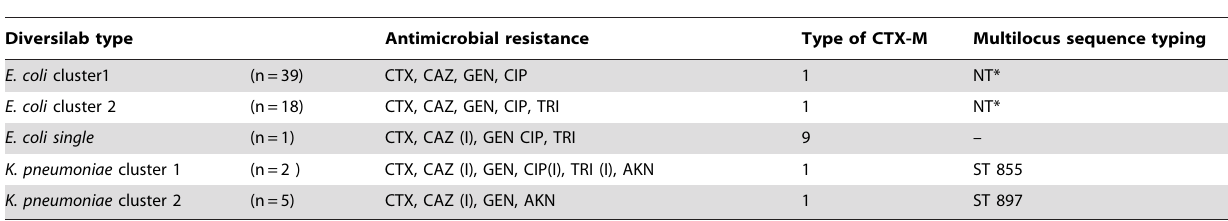
Table 2. Characteristics of ESBL-producing